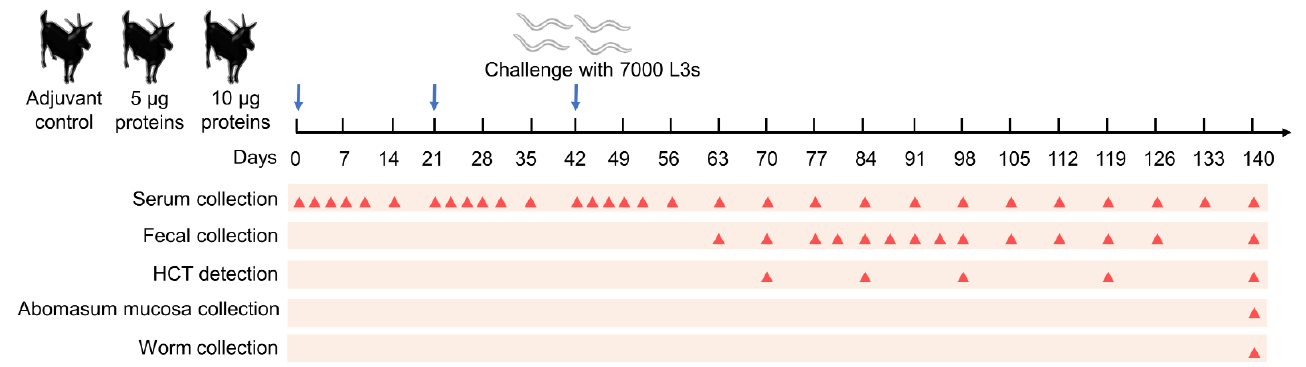
Figure 1. Animal experiment design. Three groups of five goats each were vaccinated with adjuvant alone (control), 5 μg , and 10 μg Con A -purified proteins mixed in adjuvant. All goats were injected subcutaneously thrice (days 0, 21, and 42; blue arrows) at three-week intervals and then challenged with 7000 third-stage larvae (L3s) on day 42. The time points for serum collection (30 times), fecal collection (14 times), hematocrit (HCT) detection (five times), abomasum mucosa collection (once), and worm collection (once) are indicated by red triangles.